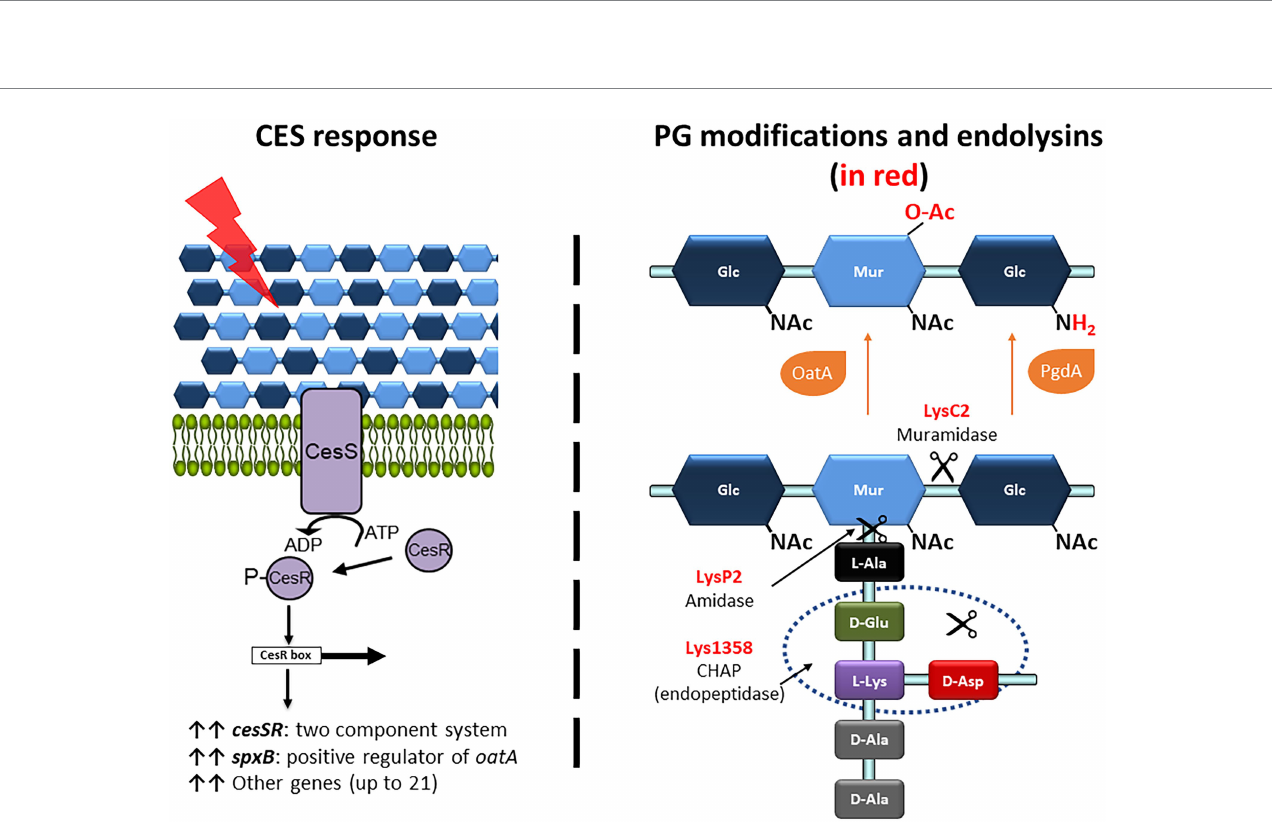
FIGURE 2 Overview of the CES response, the PG modifications and the PG bonds targeted by the lactococcal phage endolysins used in this work. (Right panel) The CES response is triggered upon damage (red ray) of the cell envelope that is sensed by the two-component system CesSR (purple proteins). The phosphorylated response regulator CesR binds to the CesR box and induces transcription of several genes, including cesSR and spxB (upright black arrows). SpxB, through binding to the RNA polymerase RpoA, drives transcription of oatA (not shown). (Left panel) The PG modifications of the N-acetyl-muramic acid (NAM) and N-acetyl-glucosamine (NAG) are shown in red. C 6 - O -acetylation and de- N -acetylation are mediated by OatA and PgdA, respectively (orange proteins). The bonds hydrolyzed by the endolysins LysC2, LysP2 and Lys1358, according to their conserved catalytic domains, are pointed by the